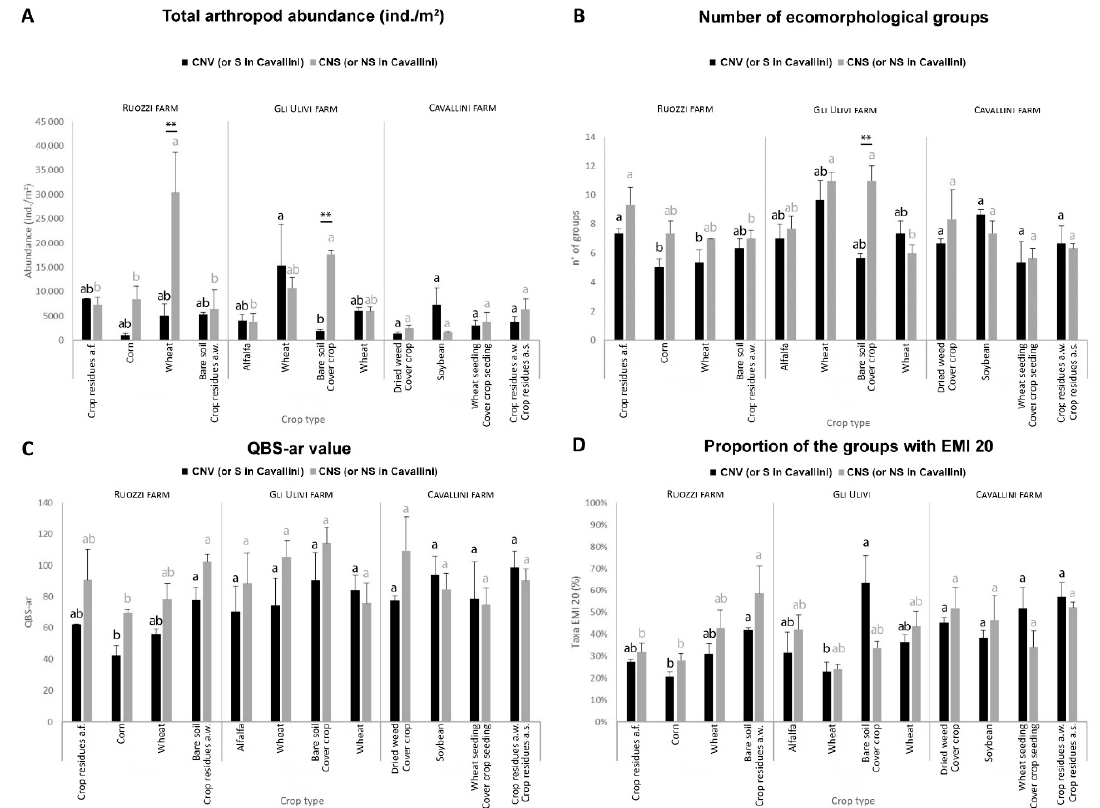
Figure 3. Barplots and standard error of ( A ): total arthropod abundance (ind./m 2 ); ( B ): number of ecomorphological groups; ( C ): QBS-ar value; ( D ): the proportion of groups with EMI 20. Results for crop types in the three farms are shown; after annual forage crop (a.f.), after wheat (a.w.) and after soybean (a.s.). In the legend, CNS: conservation (or NS: no sub-irrigation system) and CNV: conventional management (or S: sub-irrigation system). Within management, significance ( p ≤ 0.05) is indicated by different letters. Between management, significance is indicated with asterisks: ** p ≤ 0.01.